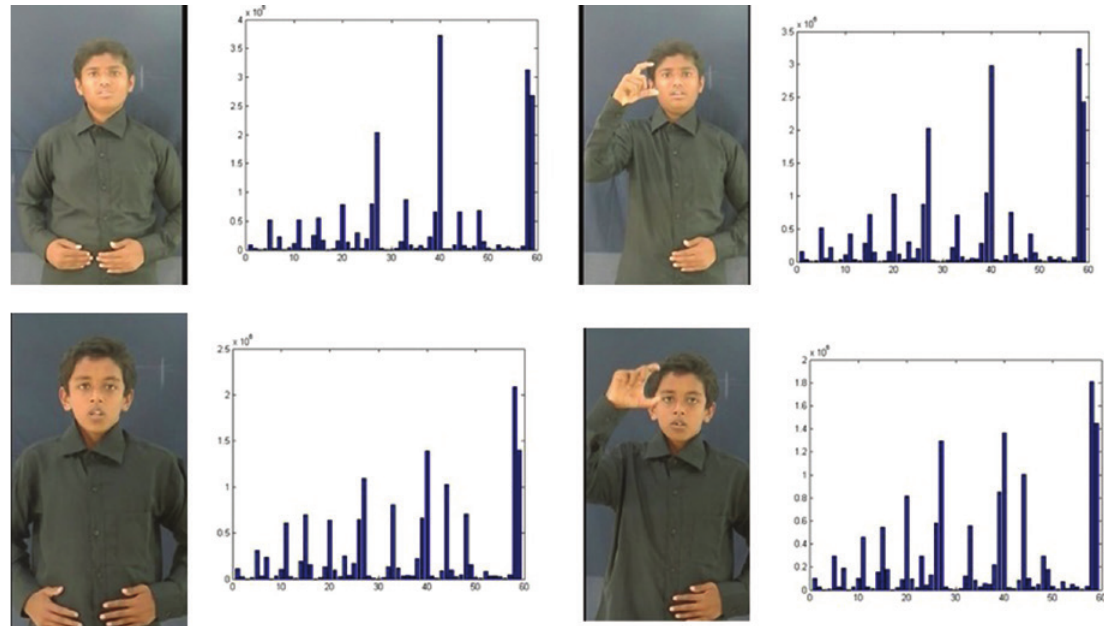
Figure 1: LBPV Histograms for Two Different Users of the Sign “I Want Coffee.”